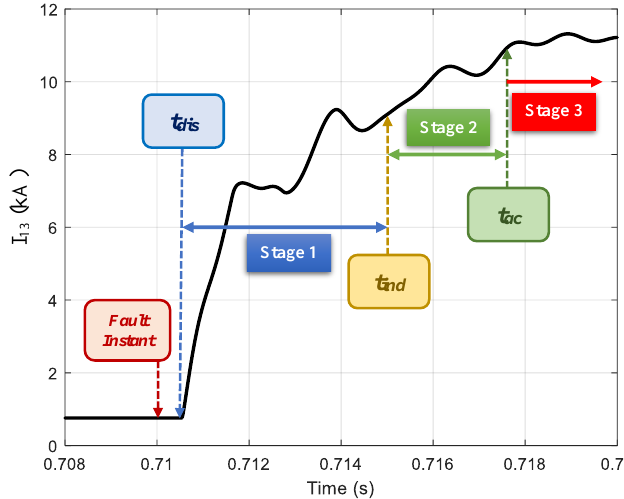
Figure 2. Positive-pole current during various stages of a DC